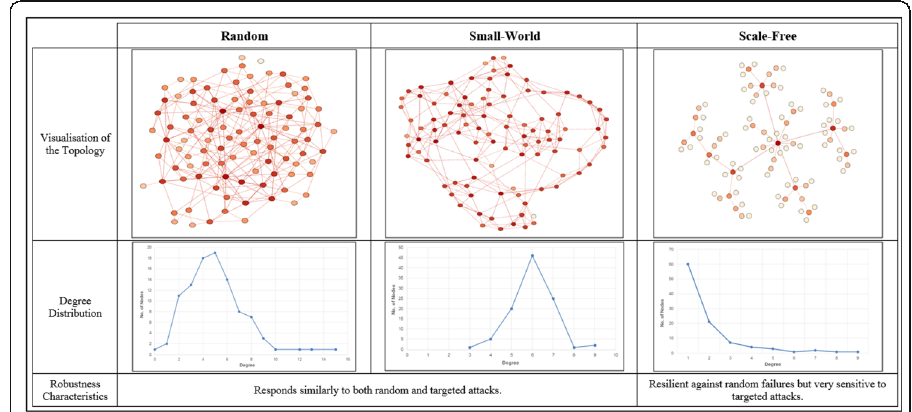
Fig. 1 Comparison of random, small-world and scale free networks. Topological structure of benchmark network models. Random and Small-world network topologies do not include hub nodes. In contrast, scale-free topologies are characterised by the presence of small number of highly connected hub nodes and a high number of feebly connected nodes. Presence of distinct hubs in scale-free networks make them more vulnerable to targeted attacks, compared to random and small-world